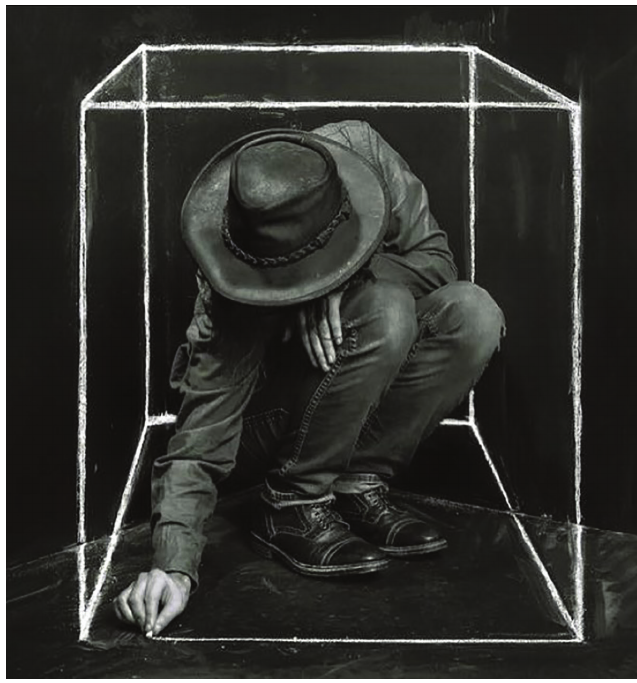
Figure 1 John Dysktra, Penalty Box